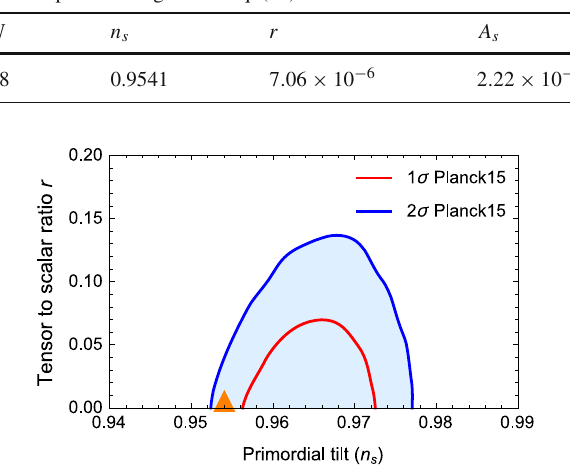
Fig. 4 A plot of the predictions for the scalar potential with F = 0, b = 3 / 2, ξ = − 1 . 005 and q = 4 . 544 × 10 − 7 and the initial condition ρ ∗ = 0 . 055 and ρ = 0 . 403 in the n end s - r plane, versus Planck’15